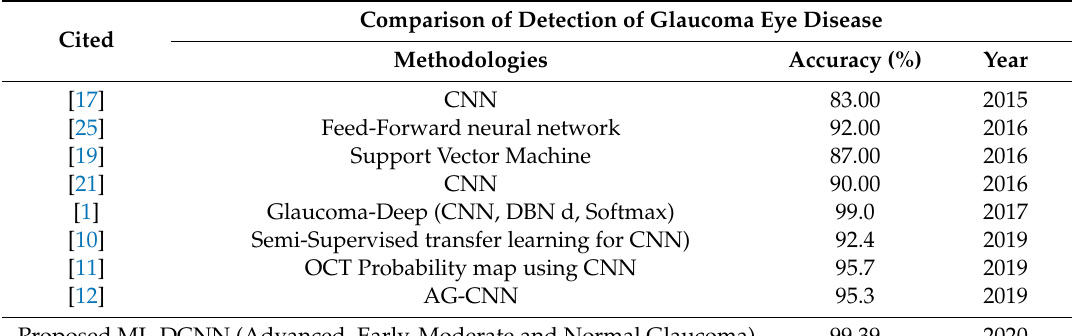
Table 6. Comparison of Accuracy value (%) of the proposed technique with the stat of the art